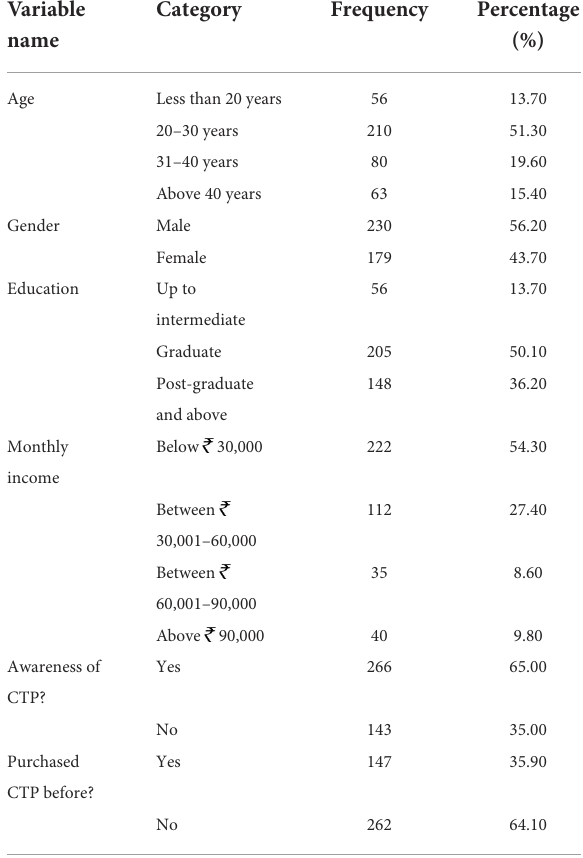
TABLE 1 Respondent’s demographic profile ( N =